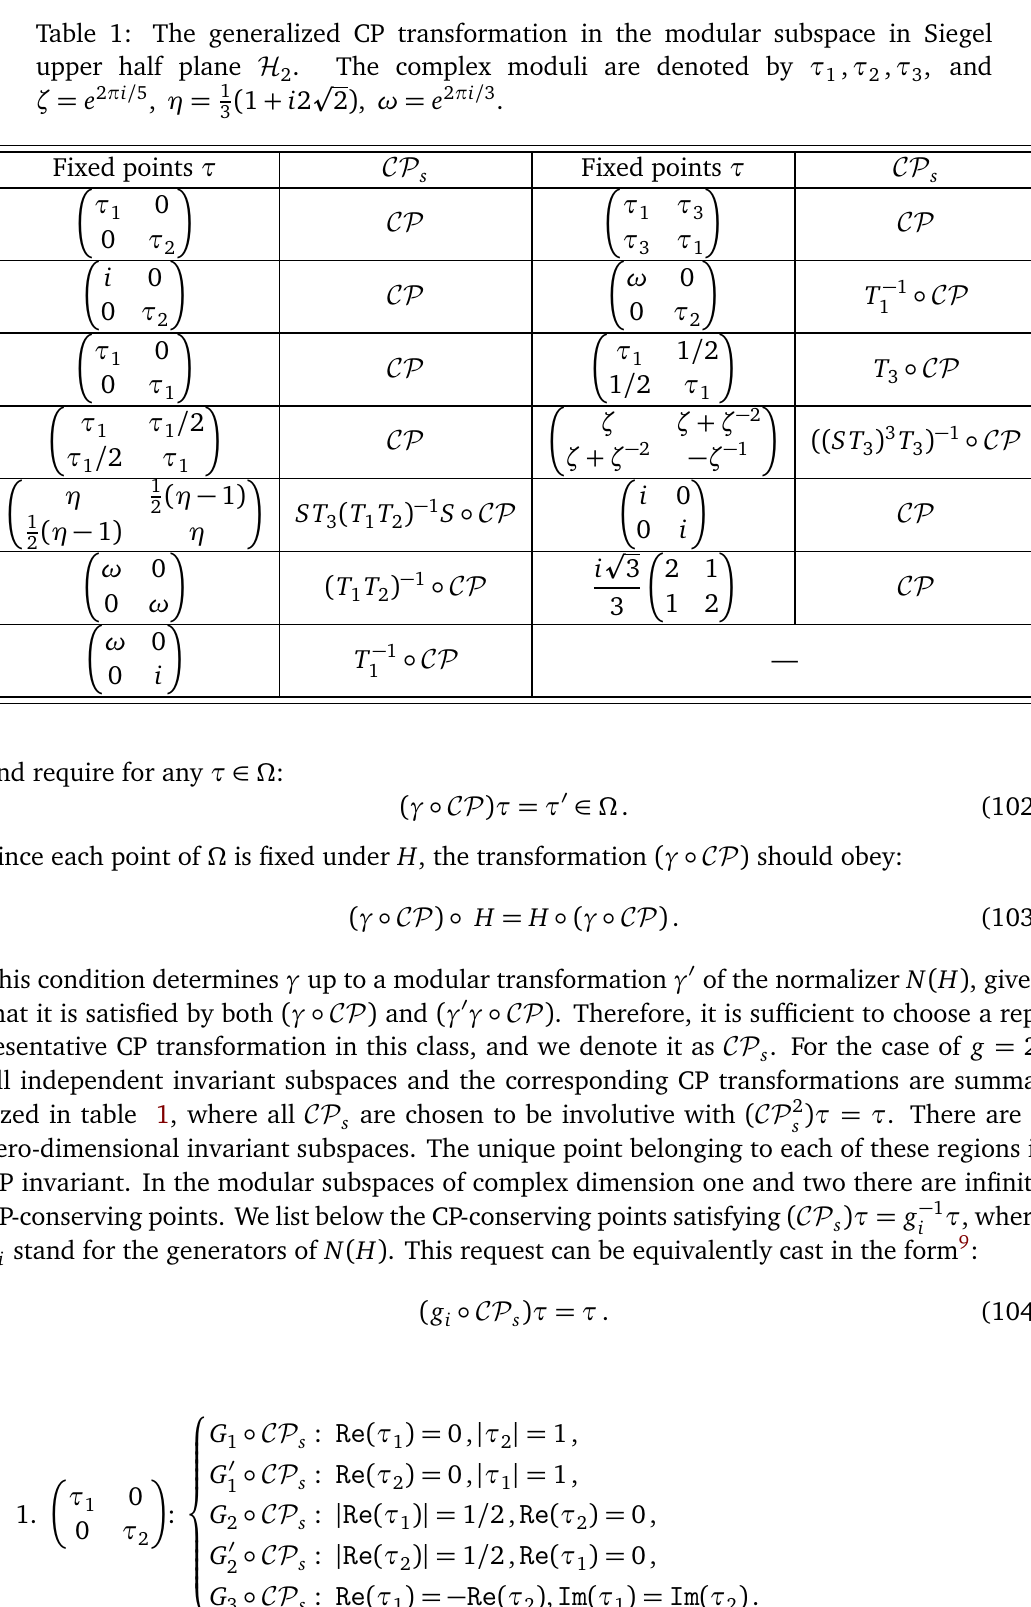
Table 1: The generalized CP transformation in the modular subspace in Siegel upper half plane H